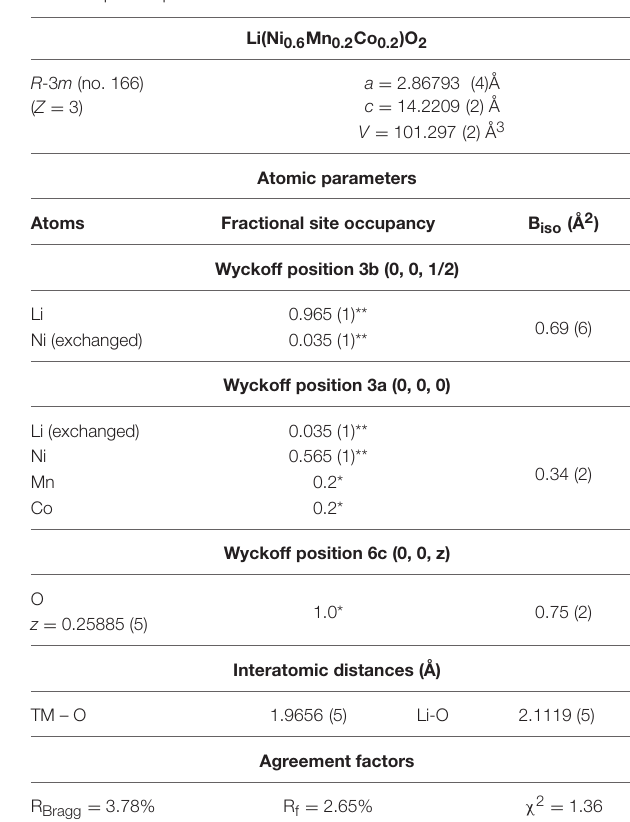
TABLE 1 | Crystallographic data obtained from the Rietveld refinement using the NCM622 pristine powder neutron diffraction